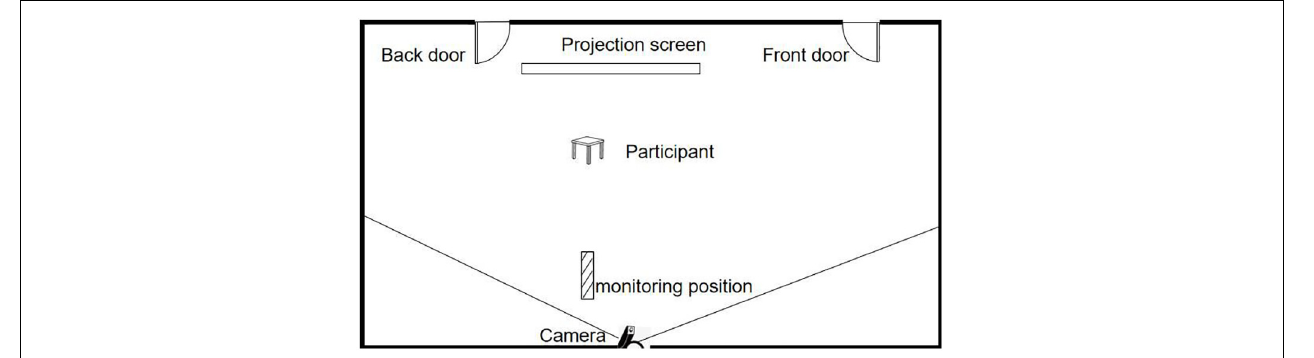
FIGURE 1 | The plane diagram of the experimental